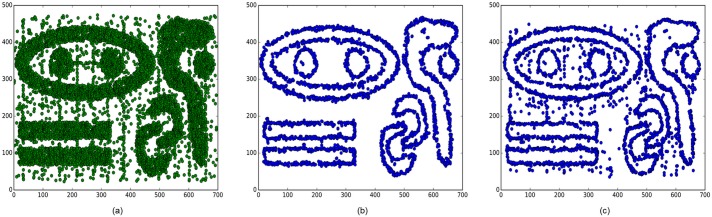
Chameleon dataset DS3 and the boundary points detection results of BV-BPD and BD-AFF methods.(a) The original data of Chameleon dataset DS3. (b) The boundary detection results of BV-BPD method. (c) The boundary detection results of BD-AFF method.